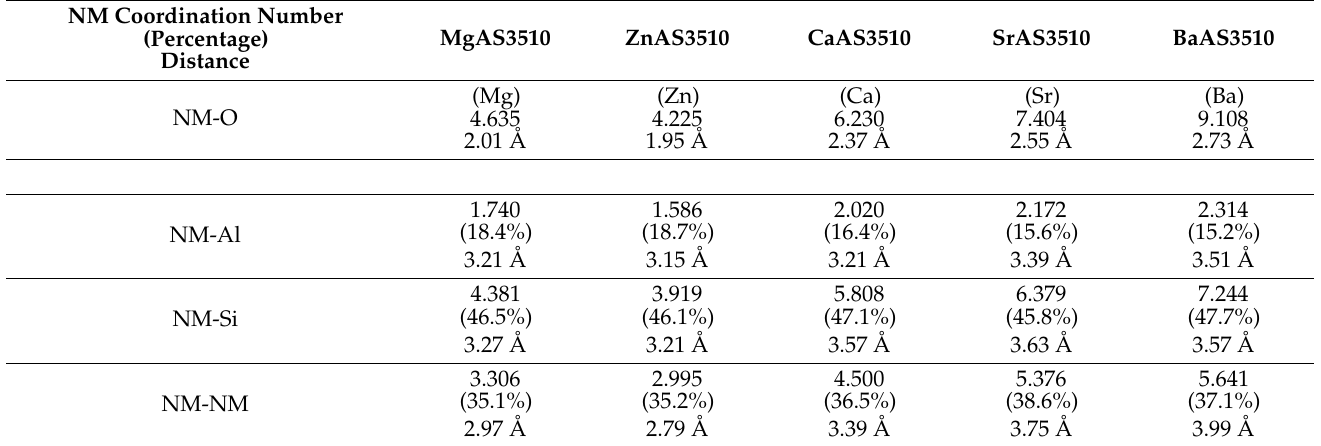
Table 3. Network modifier (NM) coordination according to molecular dynamic simulations. Upper part of the table: the coordination numbers (CN) and distances of the network modifying ions with oxygen in their first coordination sphere. Lower part: CN with Al 3+ , Si 4+ , and network modifier cations in the second coordination sphere. In the lower part, the percentages of the different cation coordinations are also